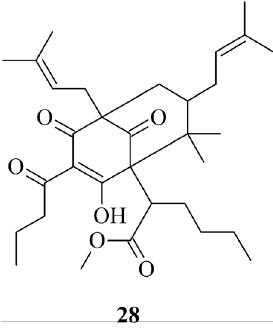
Figure 10 - New acylphoroglucinol ( 28 ) isolated from Kielmeyera variabilis